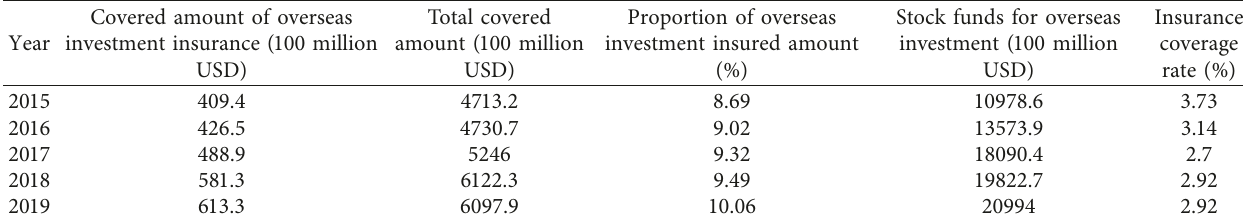
Table 4: 2015–2019 SINOSURE overseas investment insurance business and insurance coverage